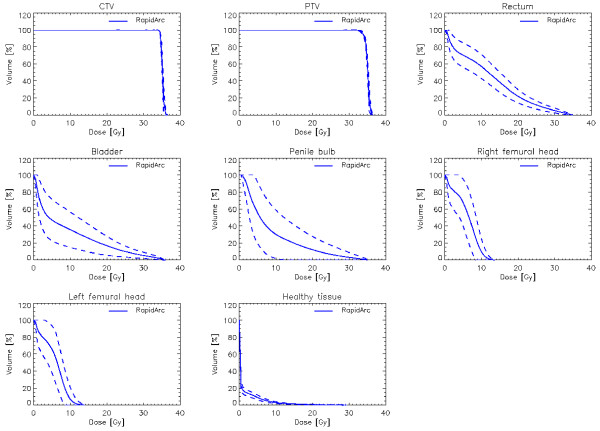
The average cumulative dose volume histograms (DVH) computed for the whole cohort of 40 patients (solid lines).